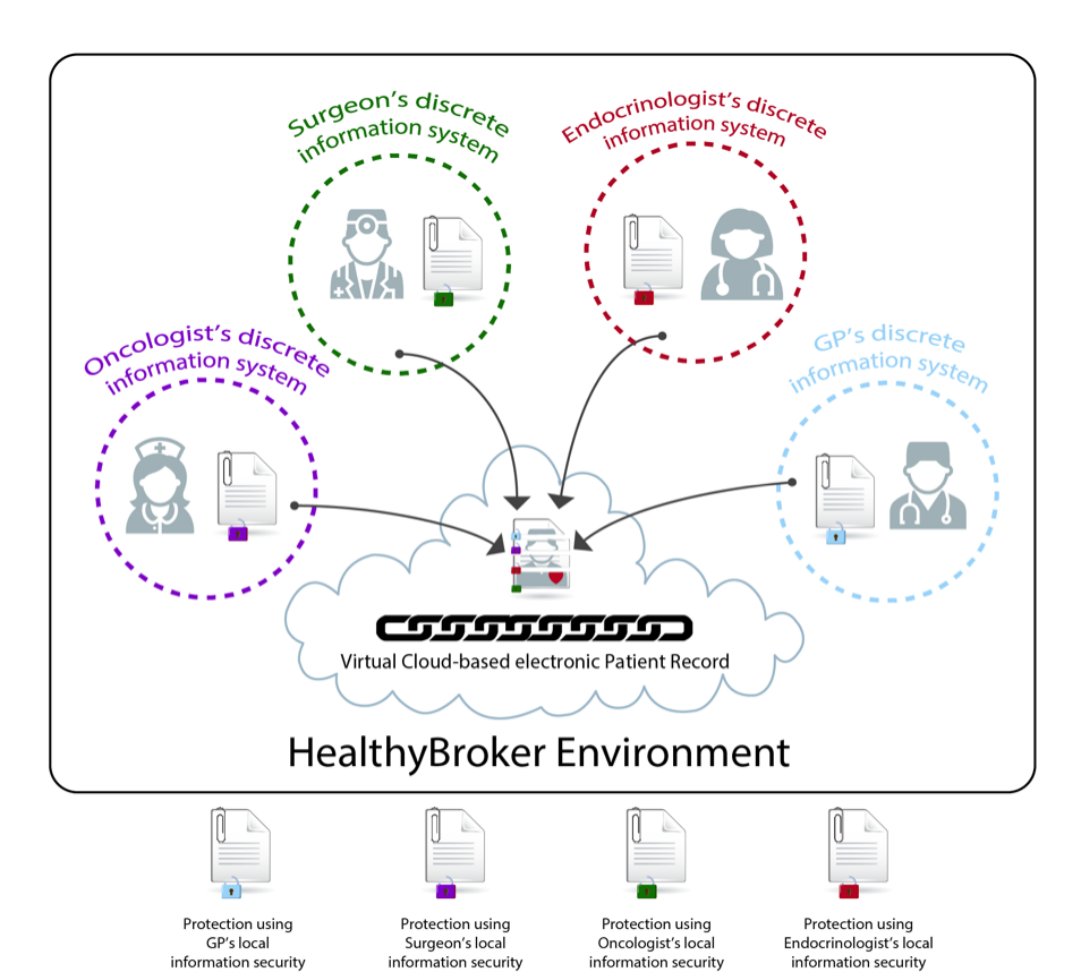
Figure 1. HealthyBroker